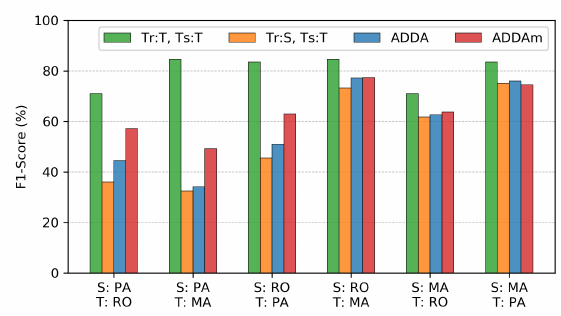
Figure 5. F1-Scores for the class deforestation for the six different scenarios and the four classification